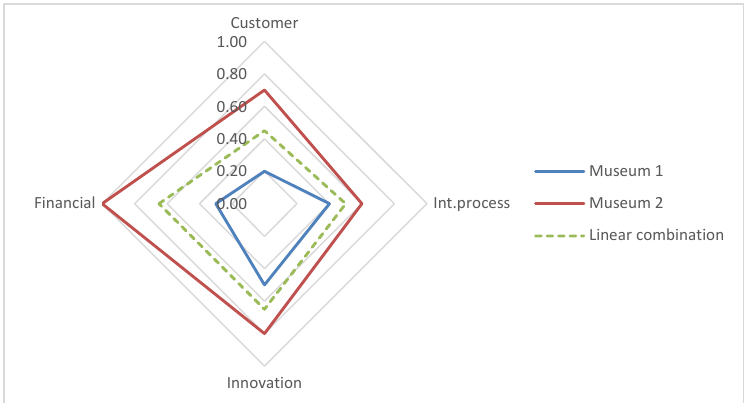
Figure 7. Radar chart showing a representative diamond of the BSC perspective scores for the museums of Example